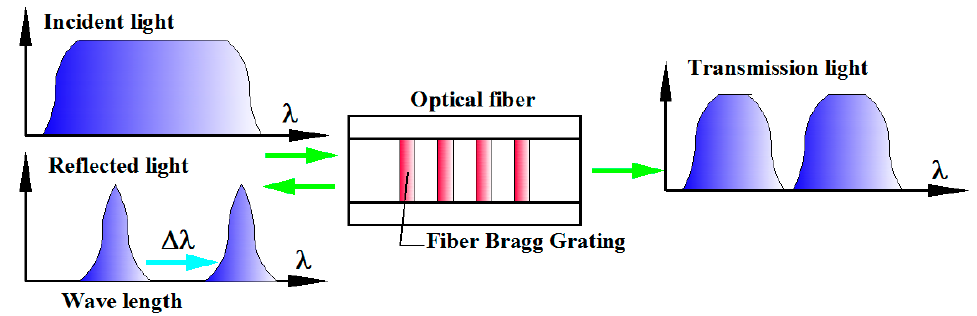
Figure 4. Schematic diagram of optoelectronic cutting force sensing approach based on Fiber Bragg grating sensor.